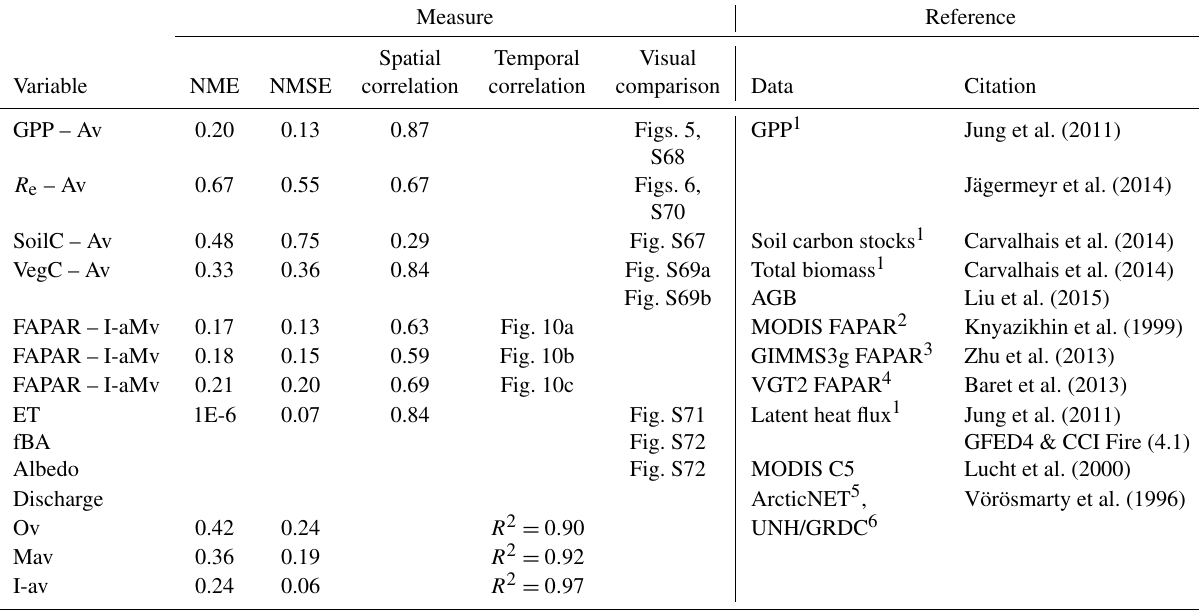
Table 4. Overview of variables evaluating LPJmL4 showing measures and references at the global